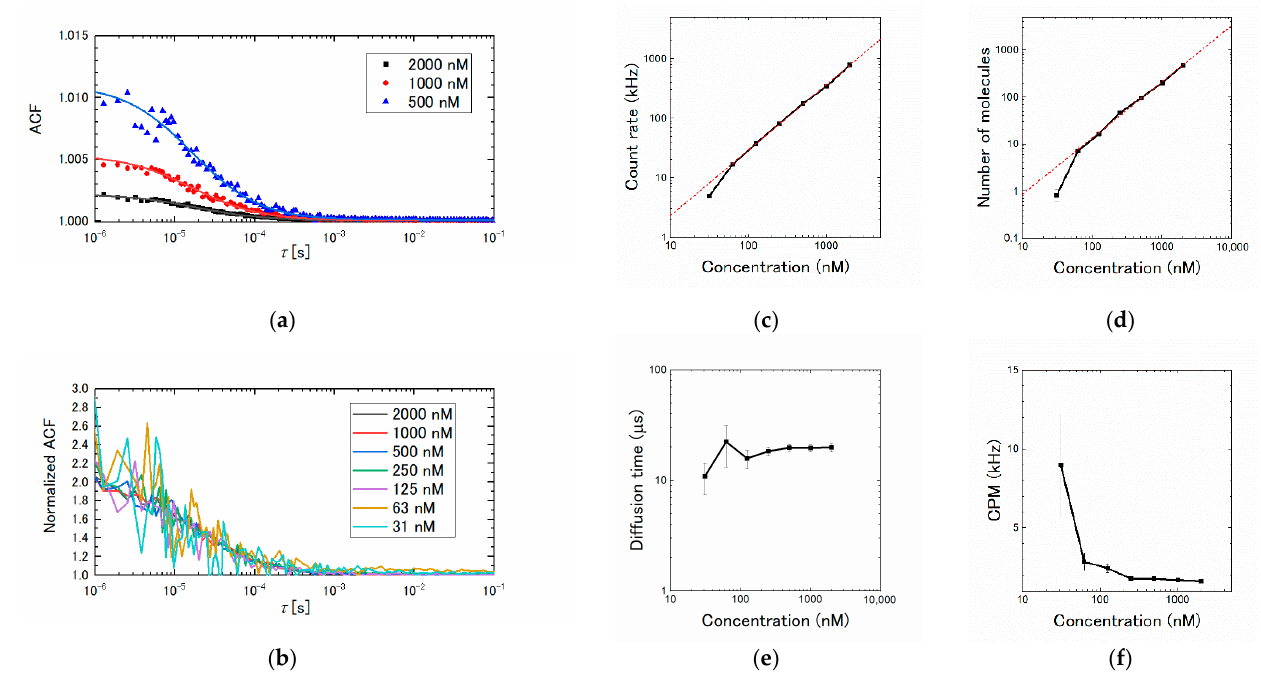
Figure 2. FB-FCS measurements on fluorescein solution. ( a ) Average ACF at different concentrations ( n = 5). The symbols show the measurement results. Solid lines are the fitting curves. ( b ) Average normalized ACFs ( n = 5). ( c ) Linear relationship between fluorescence count rate and concentration. The background count rate was subtracted. ( d ) Linear relationship between the measured number of molecules and concentration. ( e ) Measured diffusion time at each concentration. ( f ) Measured CPM at each concentration. ( c , f ) Error bars show standard error ( n = 5). Red broken lines show the results of the linear fitting.